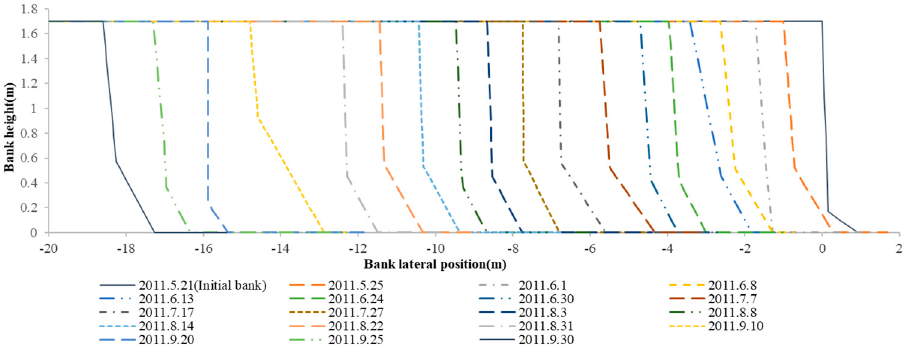
Figure 8. Collapse phases for Section 3.